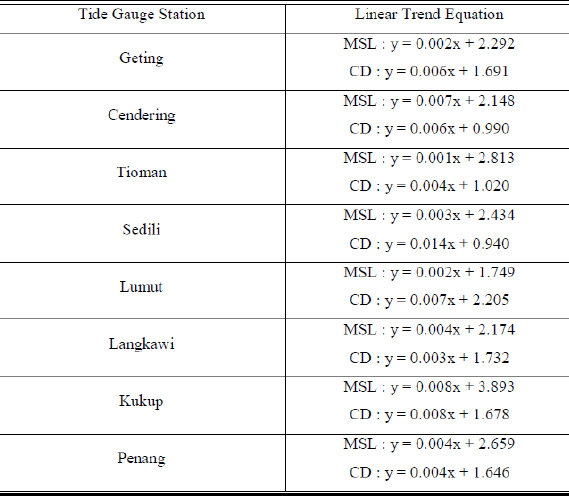
Table 1. Linear Trend Equation of all stations Therefore, from the analysis and calculation, the linear trend of MSL and CD are as stated in Table